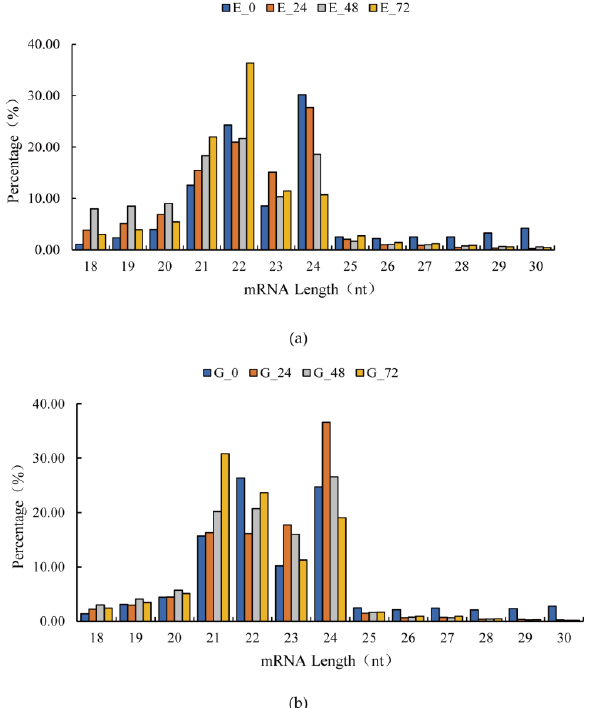
Figure 1. The sRNA length distribution. ( a ) Sequencing frequency of miRNAs in Eshu 6 with different lengths; E_0, E_24, E_48, and E_72: the infected Eshu 6 tubers at 0 h, 24 h, 48 h, and 72 h. ( b ) Sequencing frequency of miRNAs in Guang 87 with different lengths; G_0, G_24, G_48, and G_72: the infected Guang 87 tubers at 0 h, 24 h, 48 h, and 72 h. Table 2. Summary of known and novel miRNAs in different